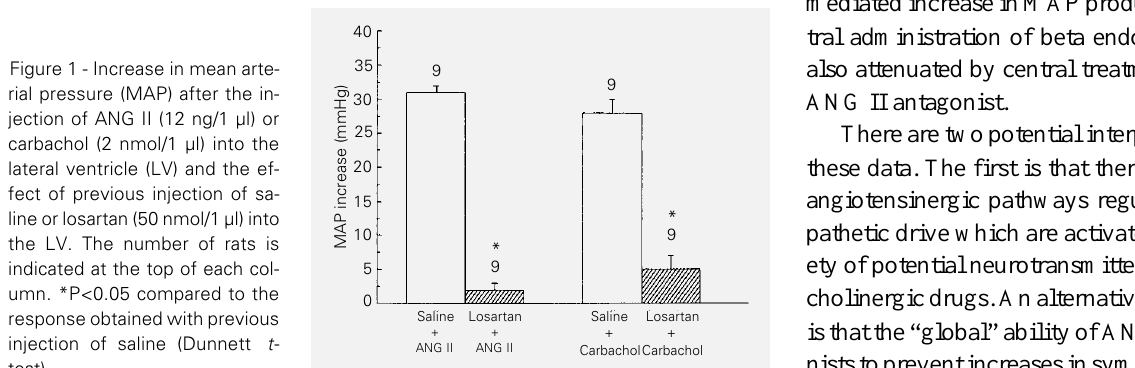
Figure 1 - Increase in mean arte- rial pressure (MAP) after the in- jection of ANG II (12 ng/1 (cid:181)l) or carbachol (2 nmol/1 (cid:181)l) into the lateral ventricle (LV) and the ef- fect of previous injection of sa- line or losartan (50 nmol/1 (cid:181)l) into the LV. The number of rats is indicated at the top of each col- umn. *P<0.05 compared to the response obtained with previous injection of saline (Dunnett t -